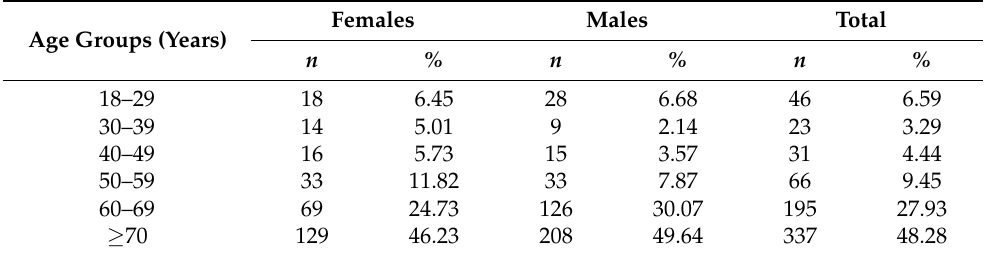
Table 2. Female and male age group distribution of the MDR uropathogens. Age Groups (Years)